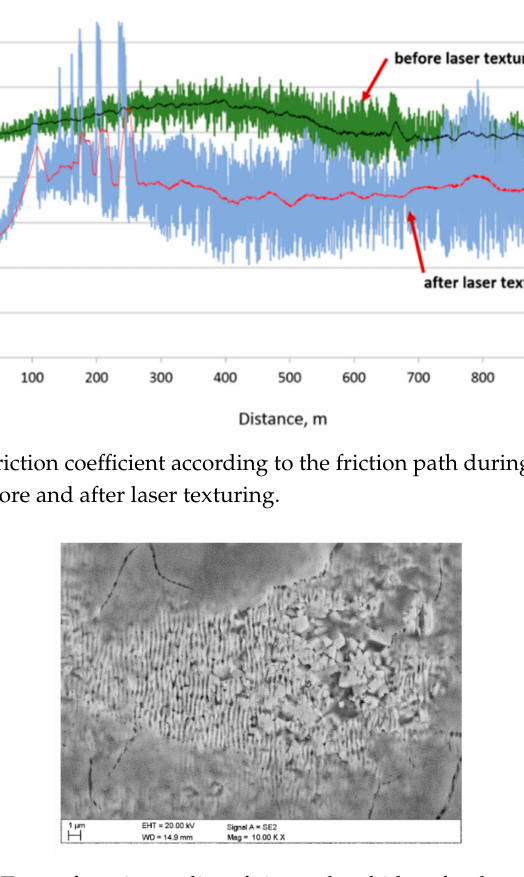
Figure 11. Trace after pin-on-disc of sintered carbides after laser